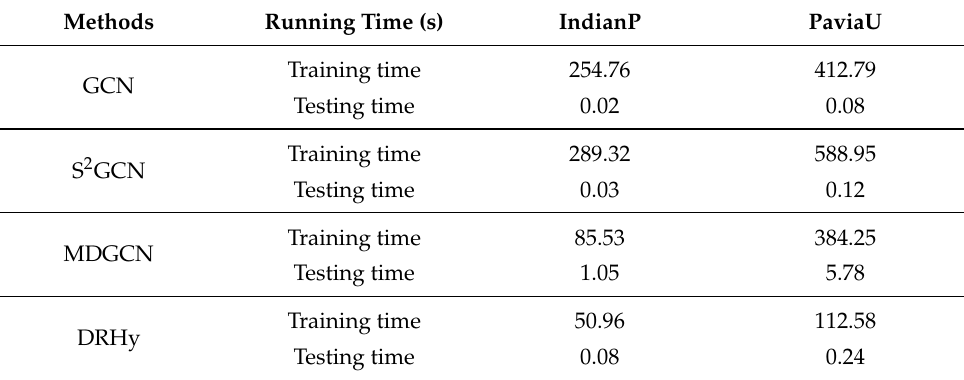
Table 7. Running times of training and testing processes of the semi-supervised learning methods.